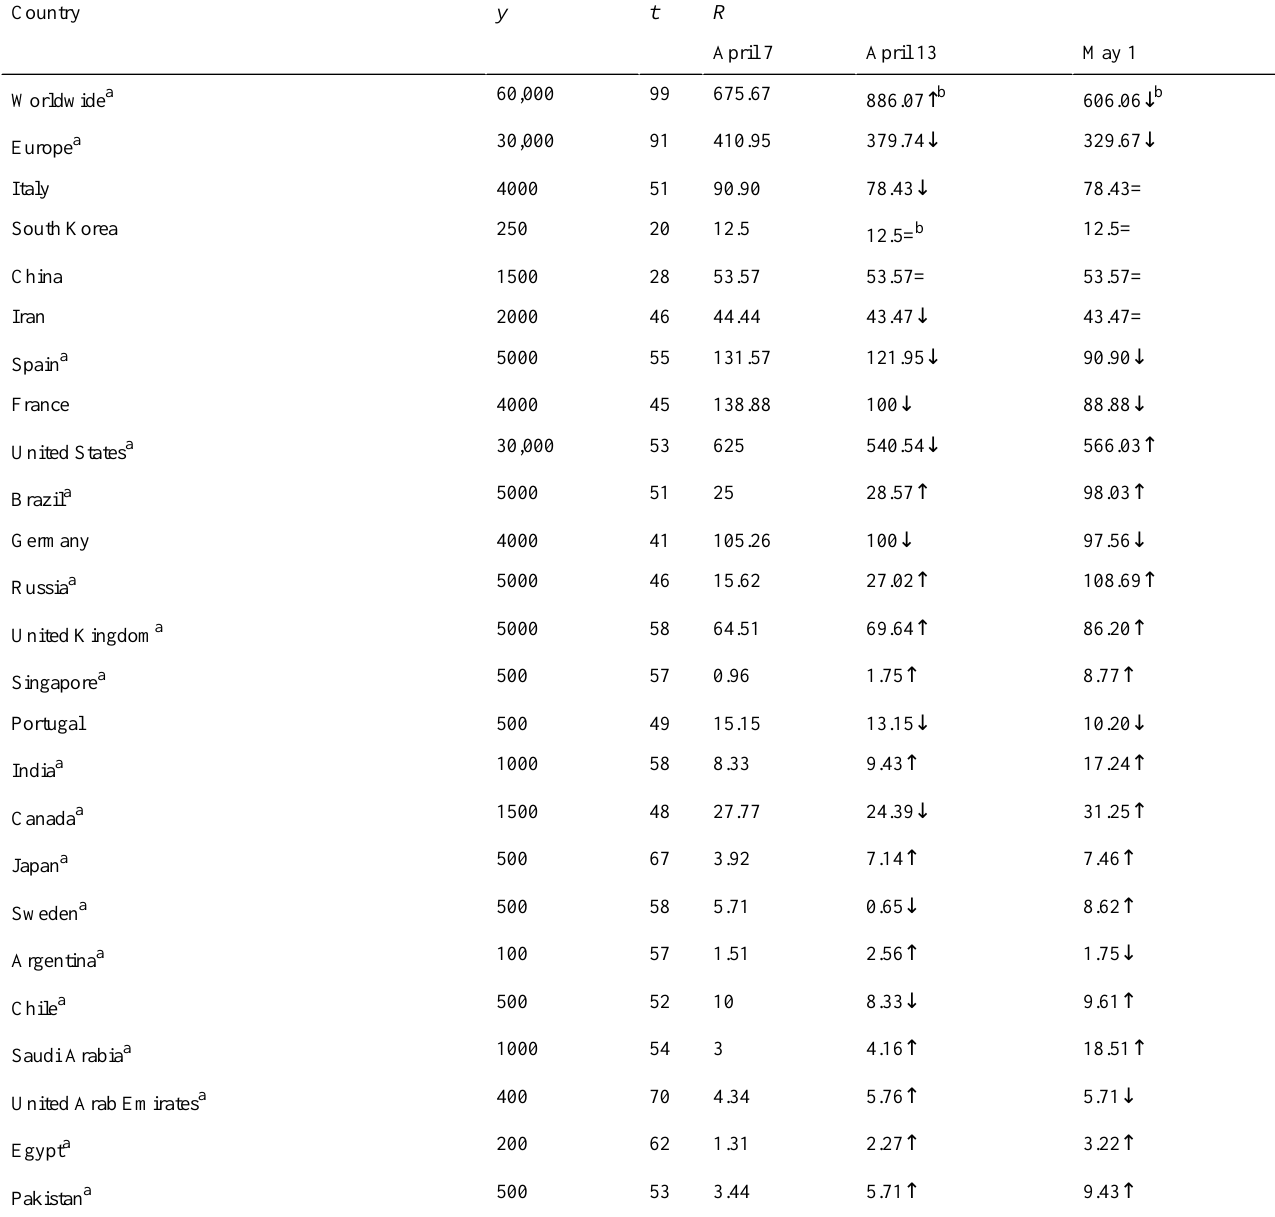
Table 2. COVID-19 maximum exponential growth patterns per population and time period by country or region from April 7 to May 1, 2020. The y and t data shown are for May 1, 2020. Data source: Worldometer